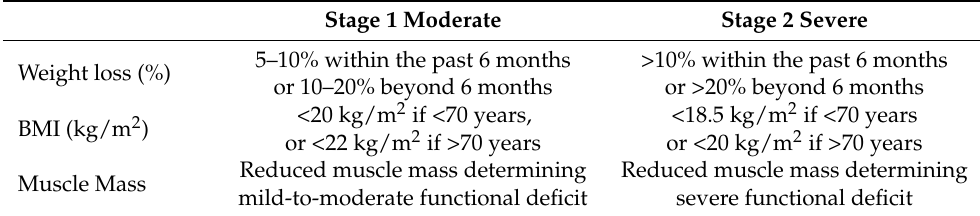
Table 2. Staging of malnutrition based on phenotypic